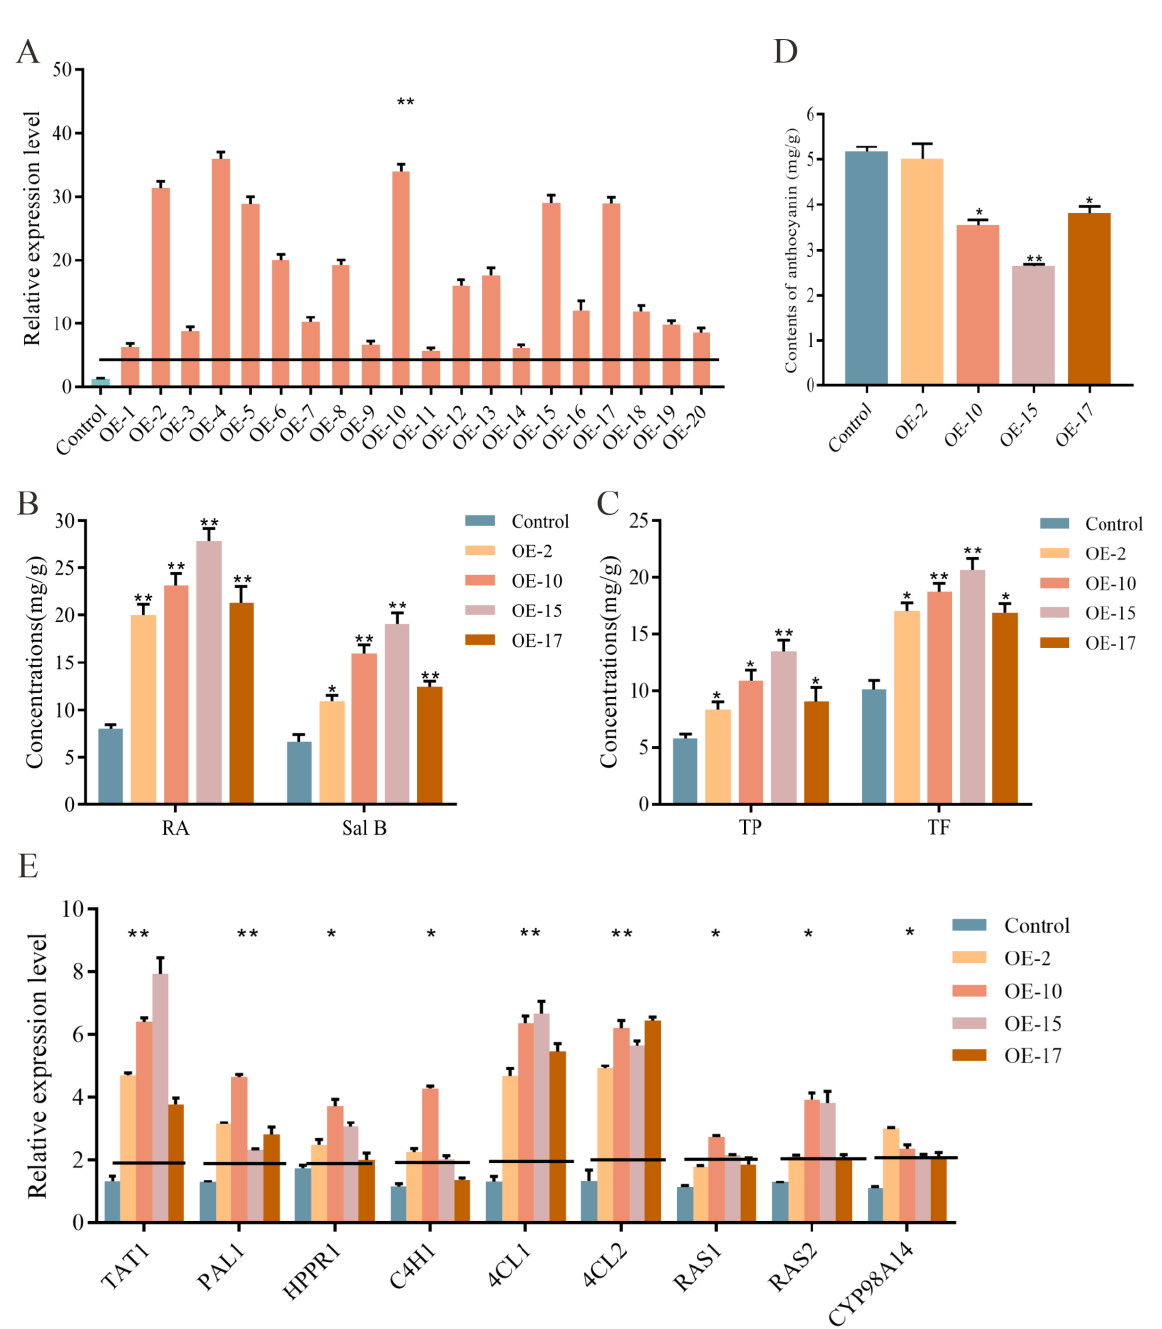
Figure 7. Effects of overexpressed SmLAC3 on the phenolic acid biosynthesis pathway. ( A ) qRT-PCR analysis of SmLAC3 expression in transgenic and control lines. ( B ) Concentrations of RA and SalB in the roots of SmLAC3 -OE and control lines. ( C ) Concentrations of TP and TF in the roots of SmLAC3 -OE and control lines. ( D ) Detection of anthocyanin content in SmLAC3 -OE and control lines. ( E ) Relative expression levels of genes involved in the SmLAC3 -OE phenolic acid pathway and control lines. All data are the means of three independent experiments, with error bars representing SD. Significant differences in comparison with the control were determined by Dunnett’s multiple comparison test (** p < 0.01; * p < 0.05).